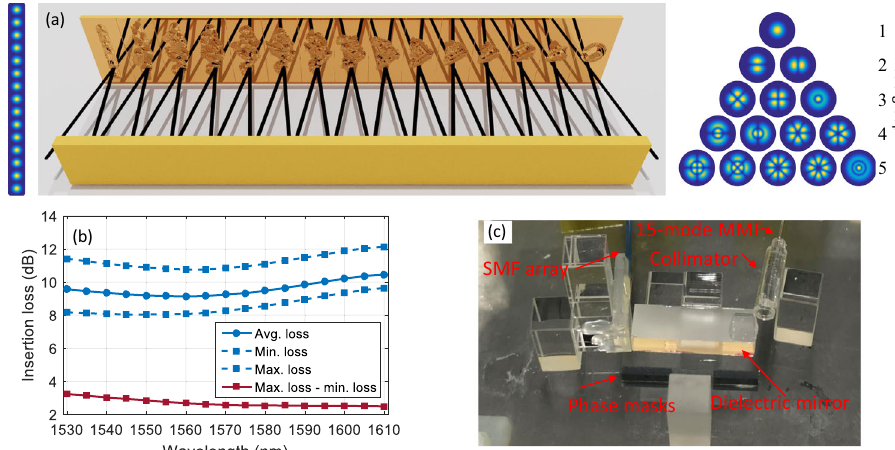
Fig. 2 Mode-multiplexer based on multi-plane light conversion. a Principle of the mode-multiplexer: 15 input beams from 15 single-mode fi bers are re fl ected 15 times between phase masks and a dielectric mirror to form orthogonal modes that can be guided by the 15-mode fi ber. b Measured wavelength-dependent loss of one mode-multiplexer. c Photograph of one mode-multiplexer.